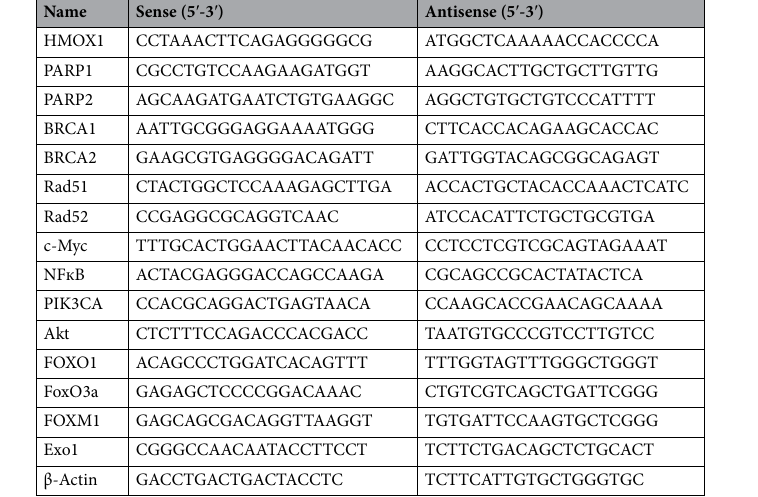
Table 2. Primer sequences for the apoptosis factors in